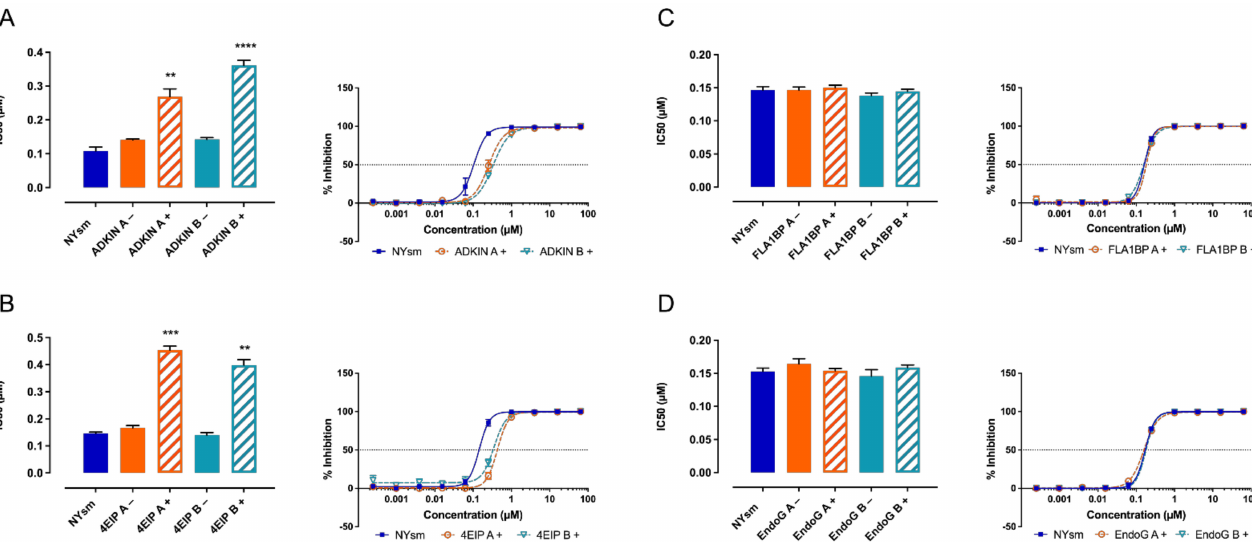
Figure 2. Effect of 5 on cell cycle regulation and RNA synthesis. ( A ) Gating strategy. ( B ) Results of the cell cycle analysis after 24 h exposure to different concentrations of 5. Results of the cell cycle analysis (2N, S phase, 4N) expressed in total cell numbers. ( C ) n = 2 and relative cell numbers. ( D ) n = 2. ( E ) Total RNA yield from trypanosomes exposed for 24 h to different concentrations of 5 ( n = 2). RNA content quantified using quantitative reverse transcription PCR (RT-qPCR) specifically targeting SL-RNA. ( F ) n = 2 with two replicates, 18S rRNA. ( G ) n = 2 with two replicates and TERT mRNA. ( H ) n = 2 with two replicates. RNA content and transcript levels are expressed as relative to the non-treated trypanosomes (control). Error bars are SEM.